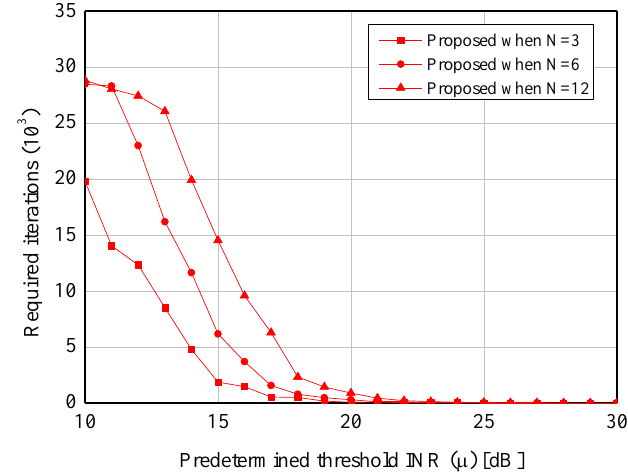
Figure 7. Performance of the sidelobe reduction algorithm—Search complexity for the proposed